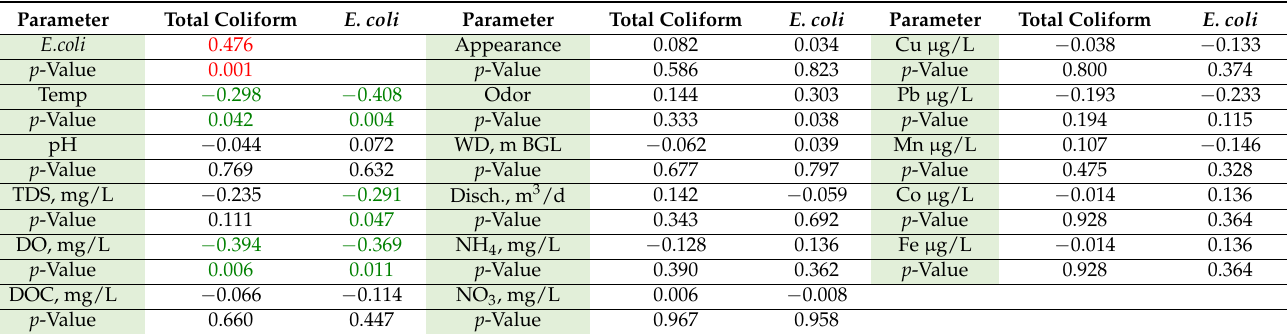
Table 2. Output matrix of the 1:1 Spearman’s rho correlation